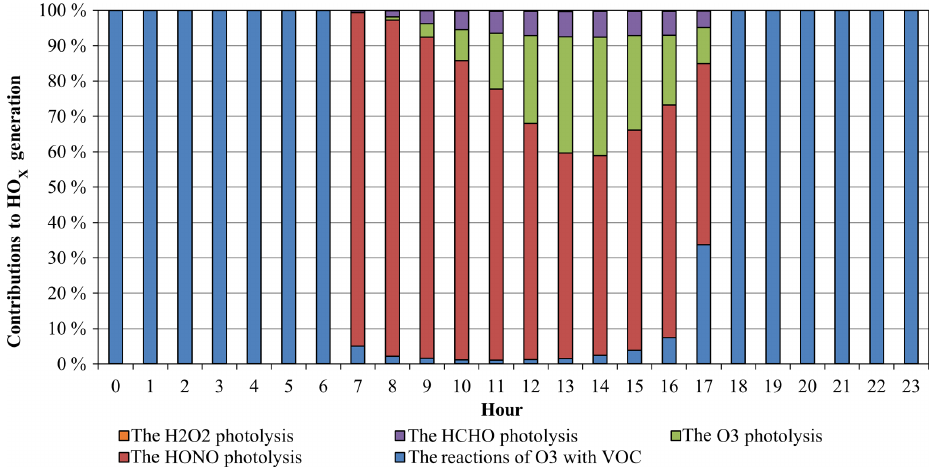
Figure 5. Average diurnal variations of contributions of different reactions to HO x generation at the Heshan site.